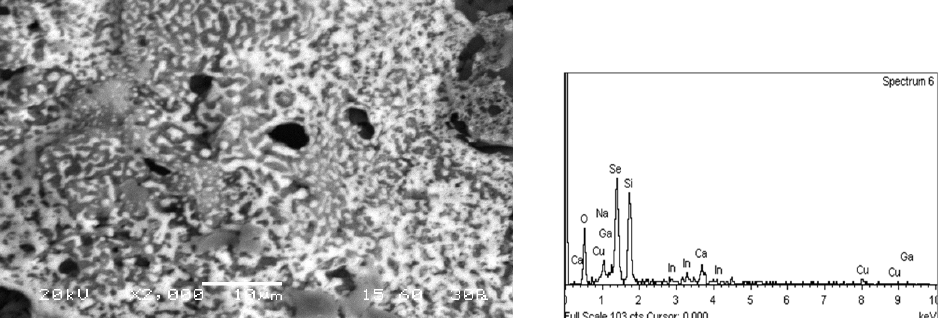
Figure 4. Solid residue upon solid/liquid separation after leaching with 6 N HNO 3.